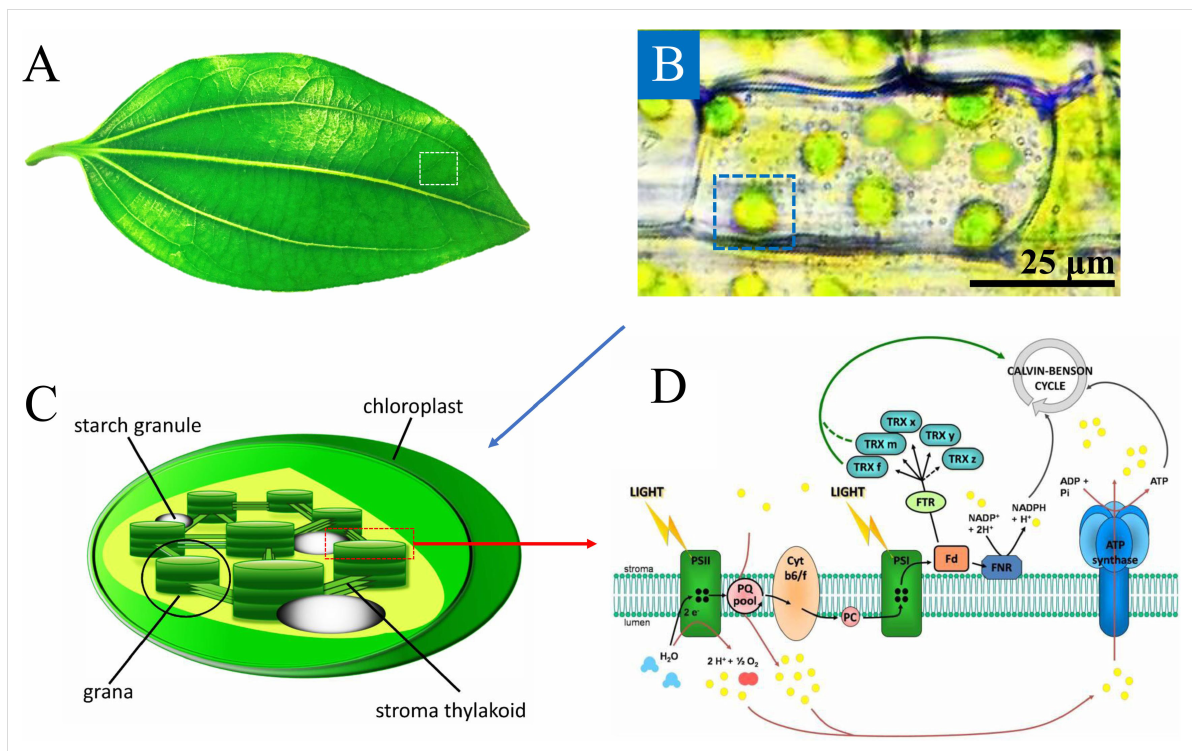
Figure 1: (A) A typical plant leaf. (B) Chloroplasts inside the plant cells. The average size of the chloroplasts is 6 µm (ranging from 3 to 10 µm). (C) Plant cell chloroplast structure. Adapted from [22], copyright BioMed Central Ltd. 2014. (D) Thylakoid membrane containing photosystem II reac- tion centers P680 and photosystem I reaction centers P700. Adapted from [23], copyright 2013 Michelet, Zaffagnini, Morisse, Sparla, Pérez-Pérez, Francia, Danon, Marchand, Fermani, Trost, and Lemaire.